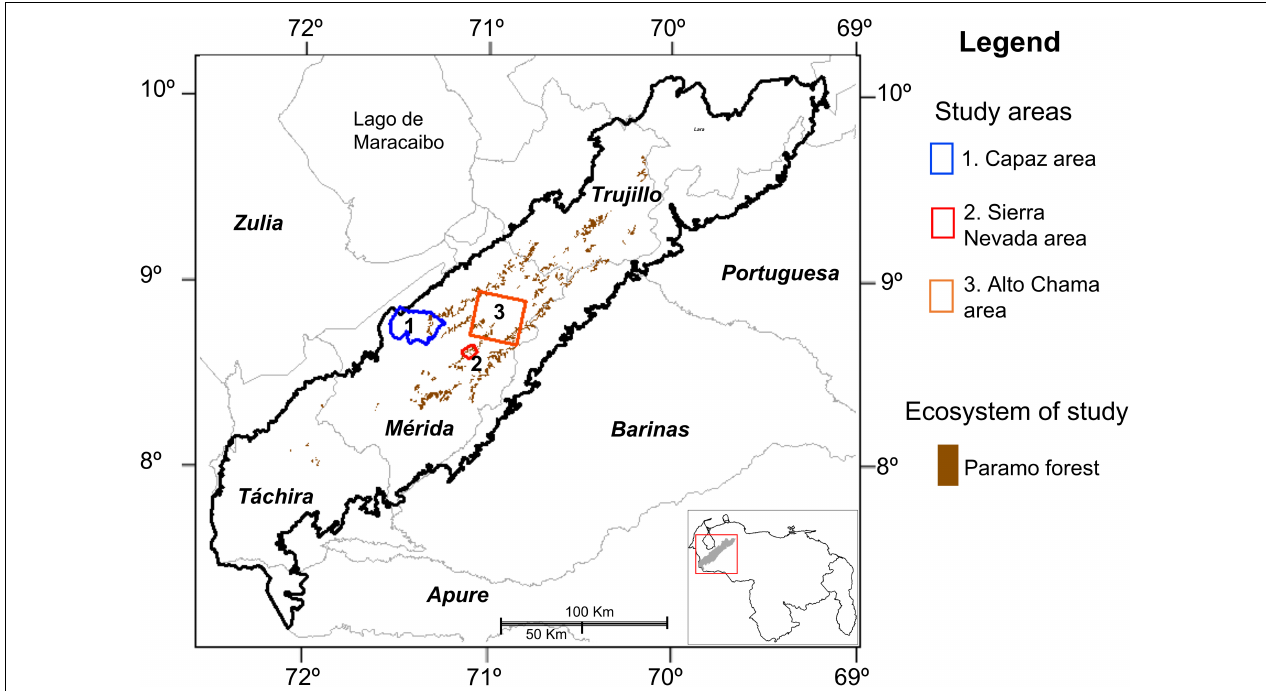
FIGURE 1 | Map of the Venezuelan Andes Ecoregion (Cordillera de Mérida) into the national context. State political divisions and names are presented. The three study areas are shown as well as the main ecosystem of study in this work.